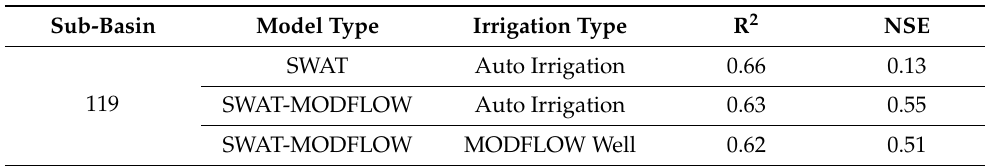
Table 2. Statistical parameters for SWAT and SWAT-MODFLOW simulated (uncalibrated) stream discharge for